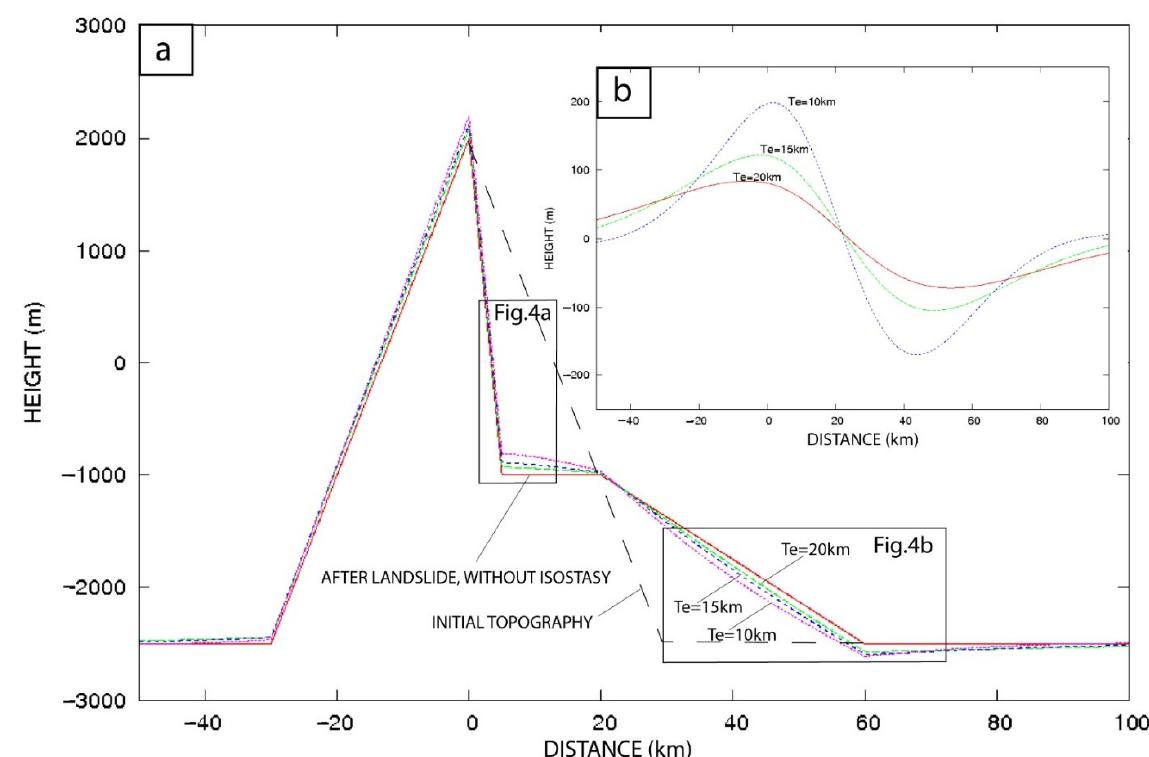
Figure 3. Vertical movements and unloading effects. ( a ) Isostatic adjustment after the large Tahiti landslide for three different elastic thicknesses. ( b ) Absolute vertical movement due to isostatic uplift and subsidence on Tahiti after the large landslide. Three different elastic thickness (T e ) values were used (10, 15, and 20 km) to simulate the vertical movement caused by isostatic response after the large landslide.